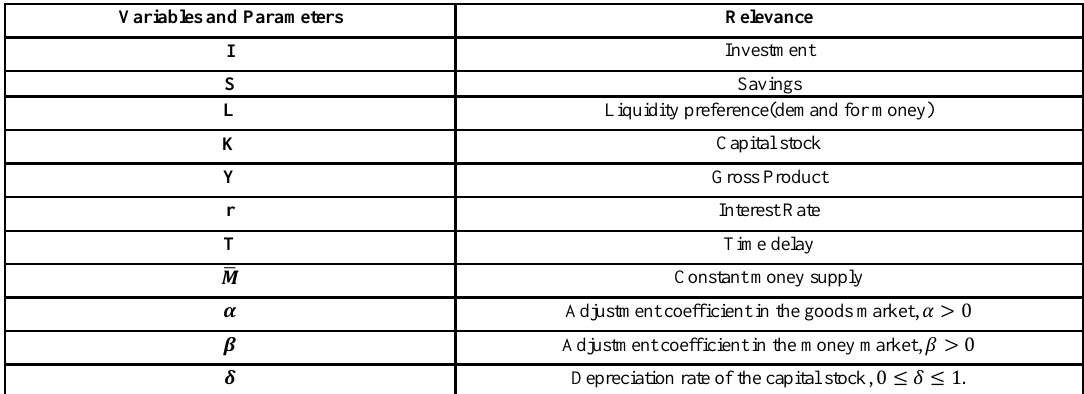
Table 1 covers all the variables and parameters that have been used in the model. Table 1. Variables and